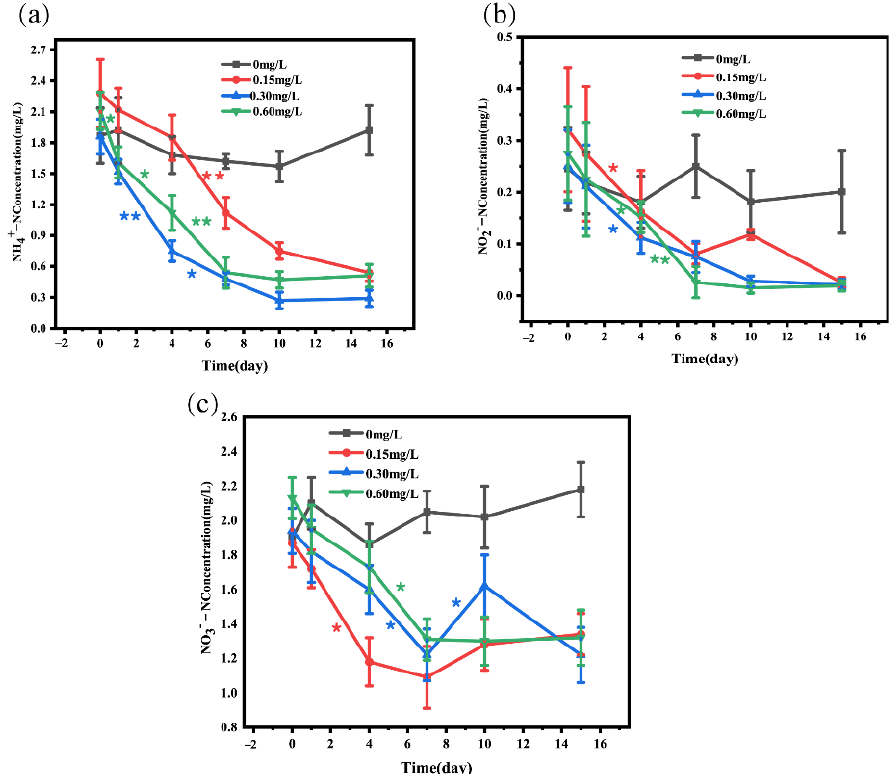
Figure 2. Concentrations of ammonia nitrogen ( a ), nitrite nitrogen ( b ), and nitrate nitrogen ( c ) in water after adding different concentrations of nitrifying and denitrifying bacteria. The black “*” indicate significant differences between 0 mg/L groups, the red “*” indicate significant differences between 0.15 mg/L groups, the blue “*” indicate significant differences between 0.30 mg/L groups, and the green “*” indicate significant differences between 0 mg/L groups. (the “*” expression p < 0.05, the “**” expression p < 0.01).